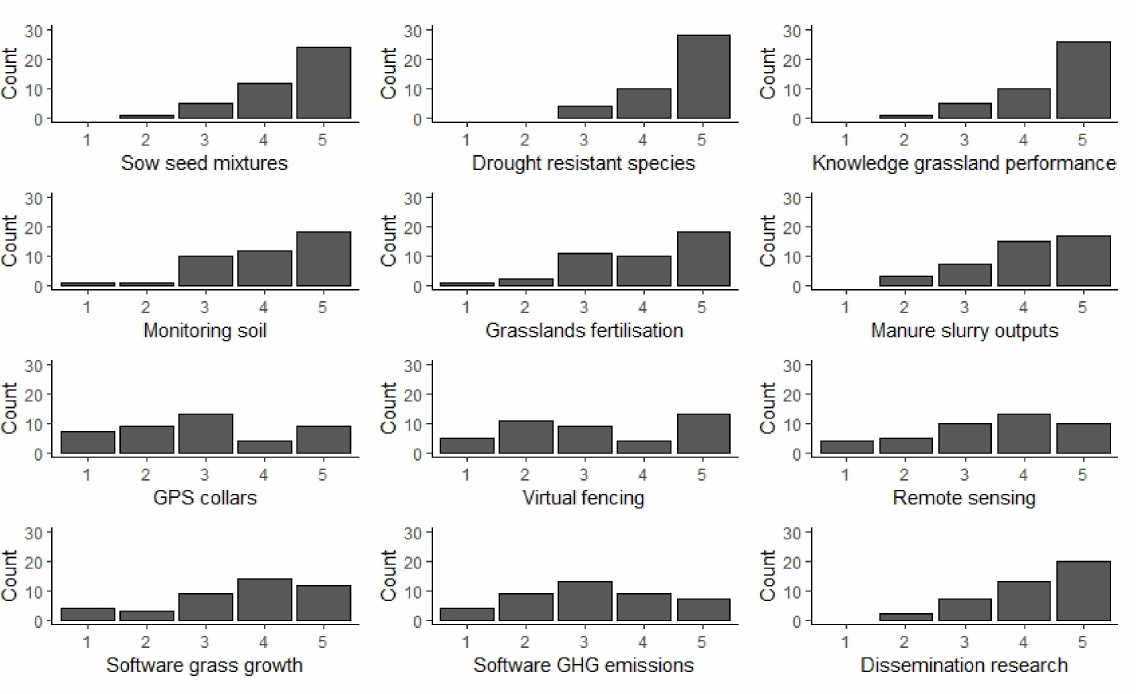
Figure 2. Histograms of relevance scores given to grassland-related innovations on the Likert scale from 1 (irrelevant) to 5 (very relevant) (N =